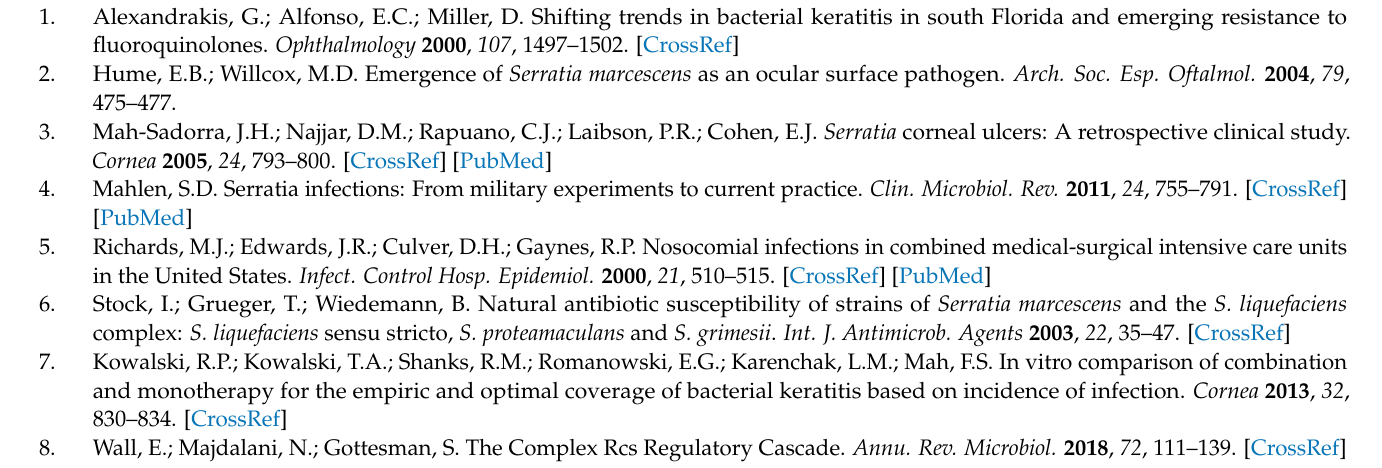
Table S2: Nucleic acids used in this study; Figure S1: Diagram of pMQ747 used in this